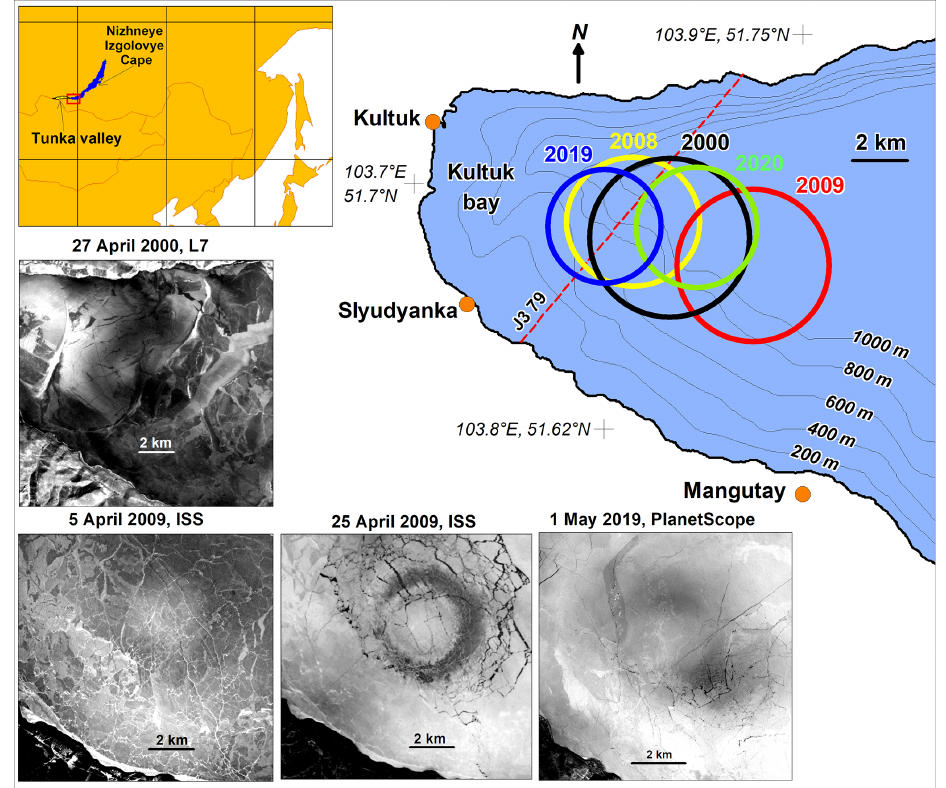
Figure 3. Overview map of the southern part of Lake Baikal with bathymetry and position of the giant ice rings in different years (coloured circles denote outer limits of ice rings) and some examples of ice rings from satellite imagery: 27 April 2000 (Landsat 7, band 4 near- infrared), 5 and 25 April 2009 – photography from ISS (red channel, georeferenced and reprojected), and 1 May 2019 (PlanetScope, near infrared band). Red dashed line marked “J3 79” – Jason-3 track no. 79 over Lake Baikal. Projection: UTM Zone 48 North